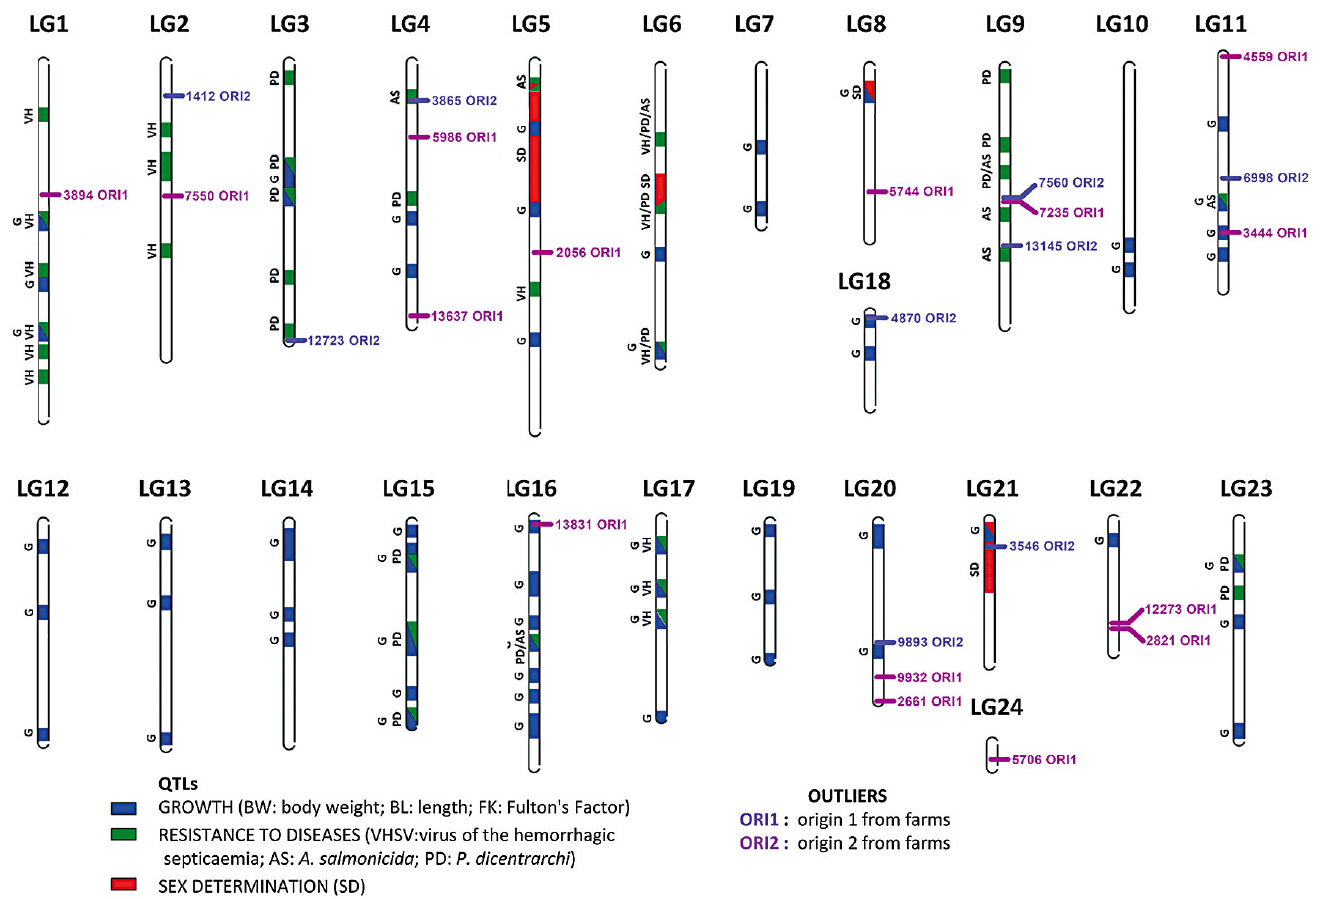
Fig. 4. Position of outlier loci related to domestication in farmed broodstock (F _ORI1 and F _ORI2 ) in the linkage groups (LG) of the turbot genetic map (from LG1 to LG23; Bouza et al.